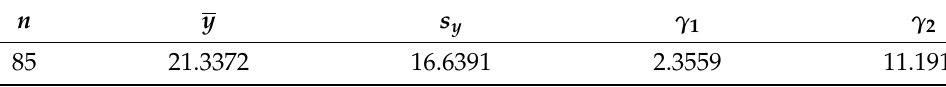
Table 4. Summary Statistics for the Nickel Concentration Data